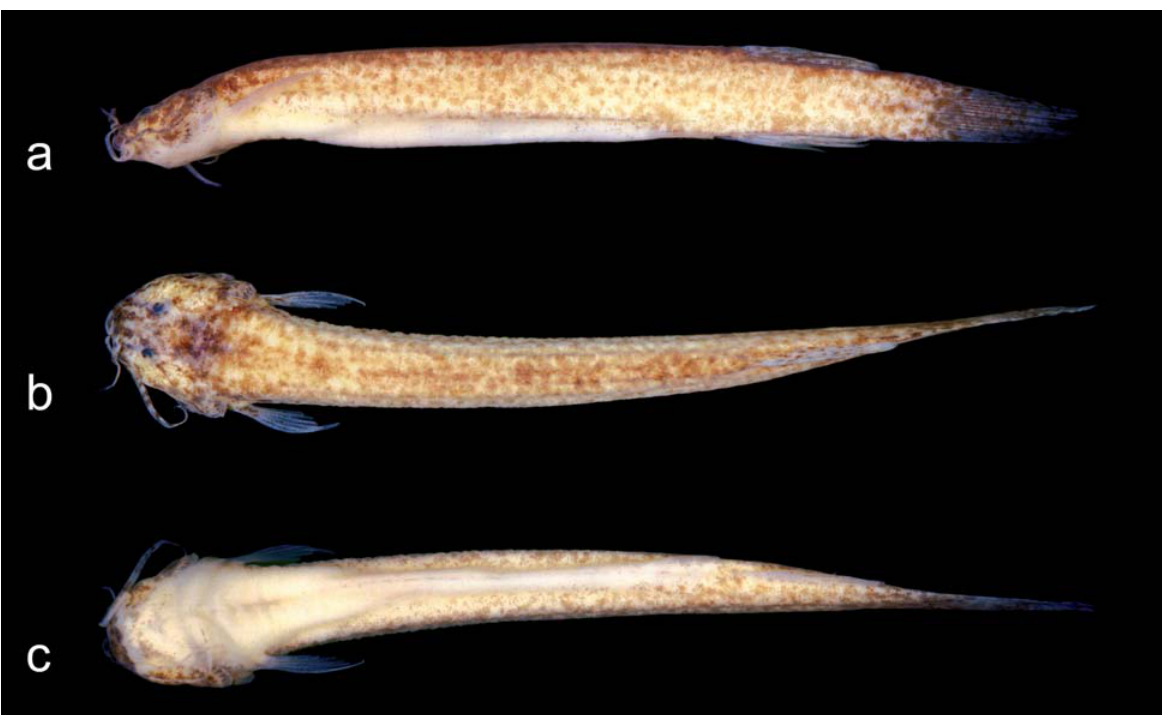
Fig. 1. Ituglanis macunaima , holotype, MZUSP 88452, 30.5mm SL; Brazil, Mato Grosso, corixo da Saudade. a, lateral view; b, dorsal view; c, ventral